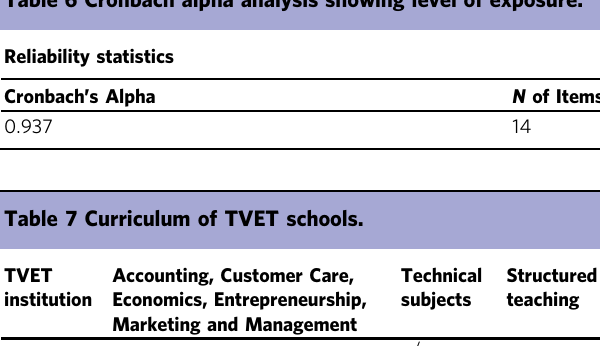
Table 6 Cronbach alpha analysis showing level of exposure.